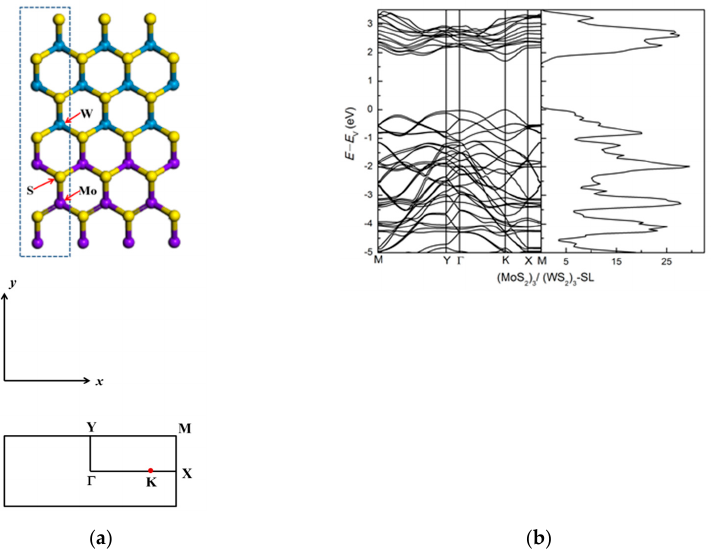
Figure 1. ( a ) The atomic structure of the lateral (MoS 2 ) 3 /(WS 2 ) 3 superlattice. The blue rectangle shows the repeat unit cell and the high-symmetry points in Brillouin zone are marked, ( b ) The electronic band structure and density of states (dos) of the superlattice. Purple ball represents Mo atoms, blue ball represents W atoms, yellow ball represents S